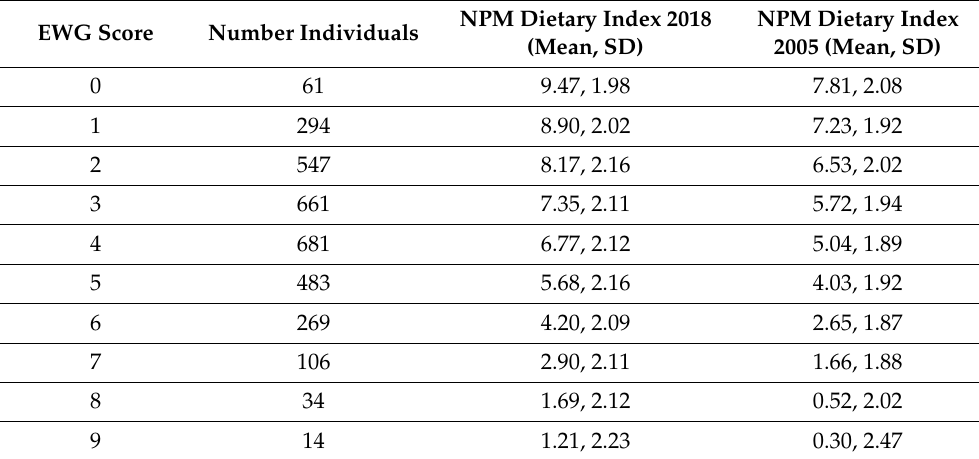
Table 1. Variation of the NPM dietary index calculated using the versions from 2005 and 2018 across levels of the EWG score.